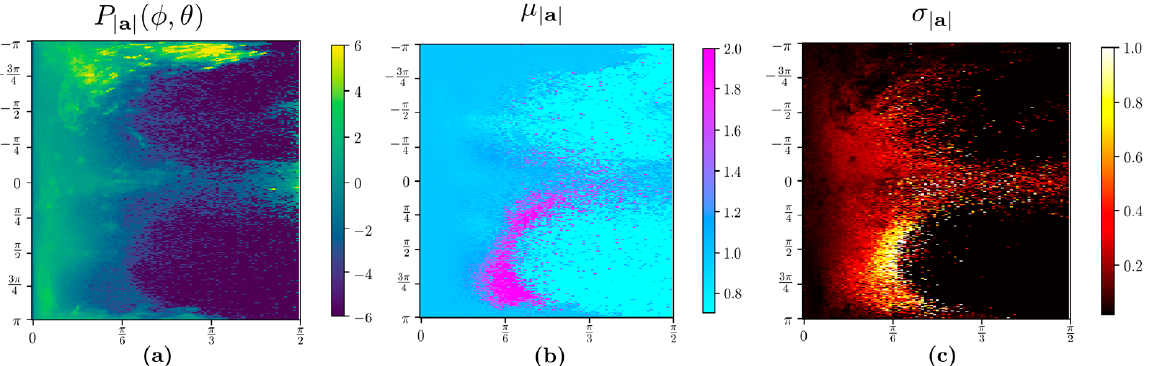
Figure 2. We can extract interesting statistics such as the probability distribution ( a ), means ( b ), and standard deviation ( c ) of the acceleration vector across the UAS by discretizing the Φ and θ features defined in Equations (2) and (3) (shown here using three different color maps). This representative data corresponds to the southern hemisphere of the UAS of an individual with stroke. The different colormaps represent different statistics.